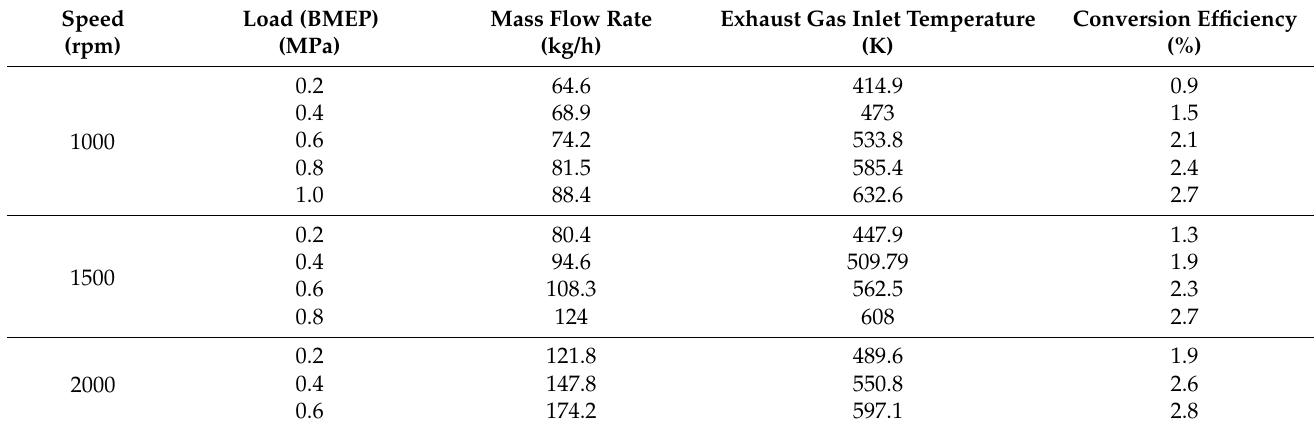
Table 5. Characteristics of thermoelectric generation